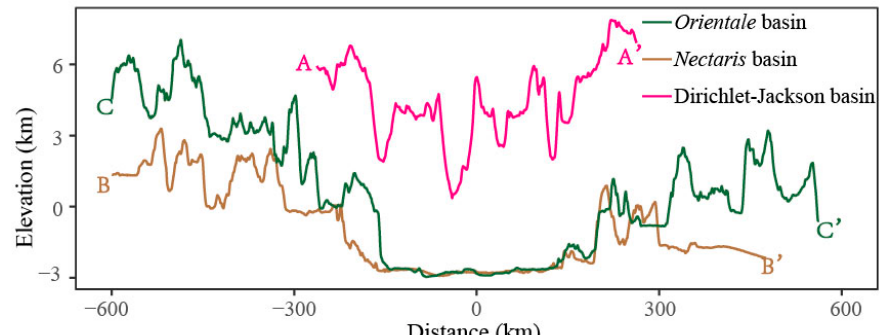
Figure 15. Topographic profile comparison map of the three basins, wherein 0 on the x -axis corre- sponds to the center of the three basins, negative values on the x -axis represent the direction from the center of the basin to the start of the topographic profile, and positive values on the x -axis represent the direction from the center of the basin to the end of the topographic profile.